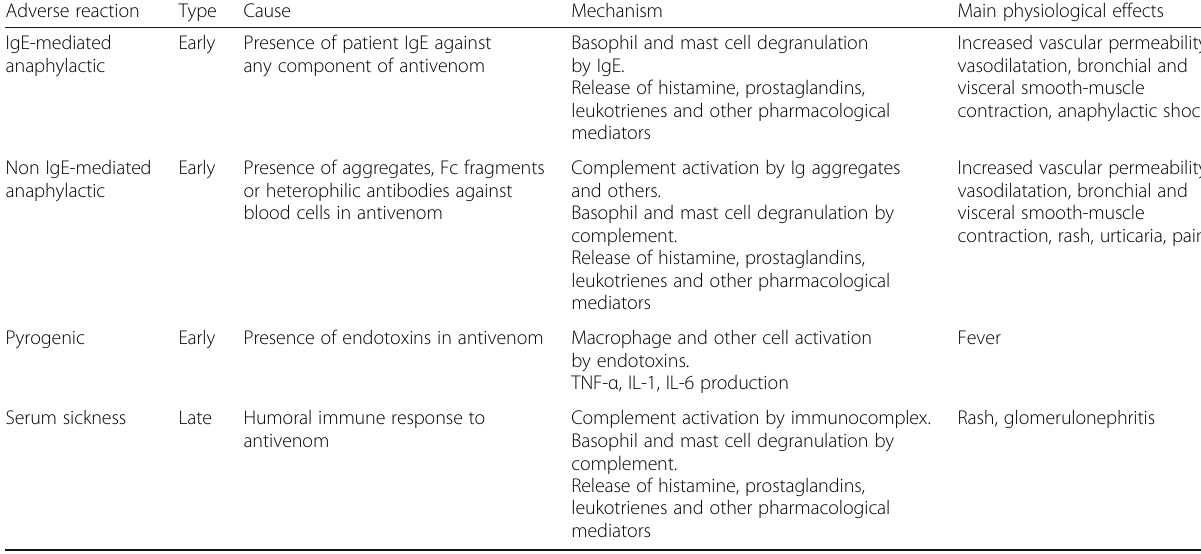
Table 1 Types of adverse reactions caused by antivenoms Adverse